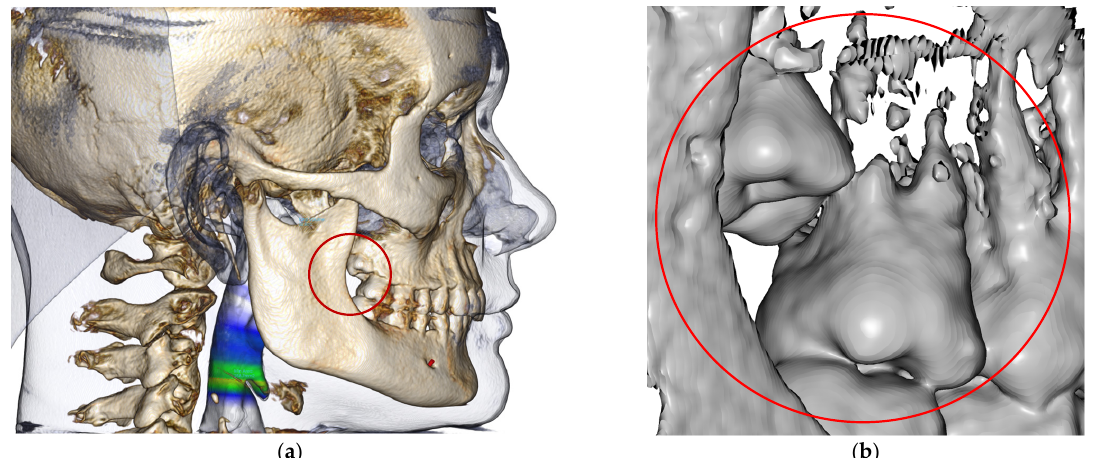
Figure 2. Example of basic processing of CBCT data in 3D visualization: ( a ) Automated processes allow trained dental assistant or nurse to prepare CBCT data for specialists; for example, orthodontists. Prepared data can allow some parts such as the airway or pathway of alveolar nerve to be recognized. Colors used in 3D visualization are taken from a template that aligns colors according to shade of gray from the Hounsfield scale and thus provide more didactic visualization. Region of interest shown in red circle; ( b ) region of interest shown in red circle is enlarged on this view. Segmentation of data images can be performed freely in opensource programs such as 3D Slicer or licensed programs such as Anatomage Medical Design